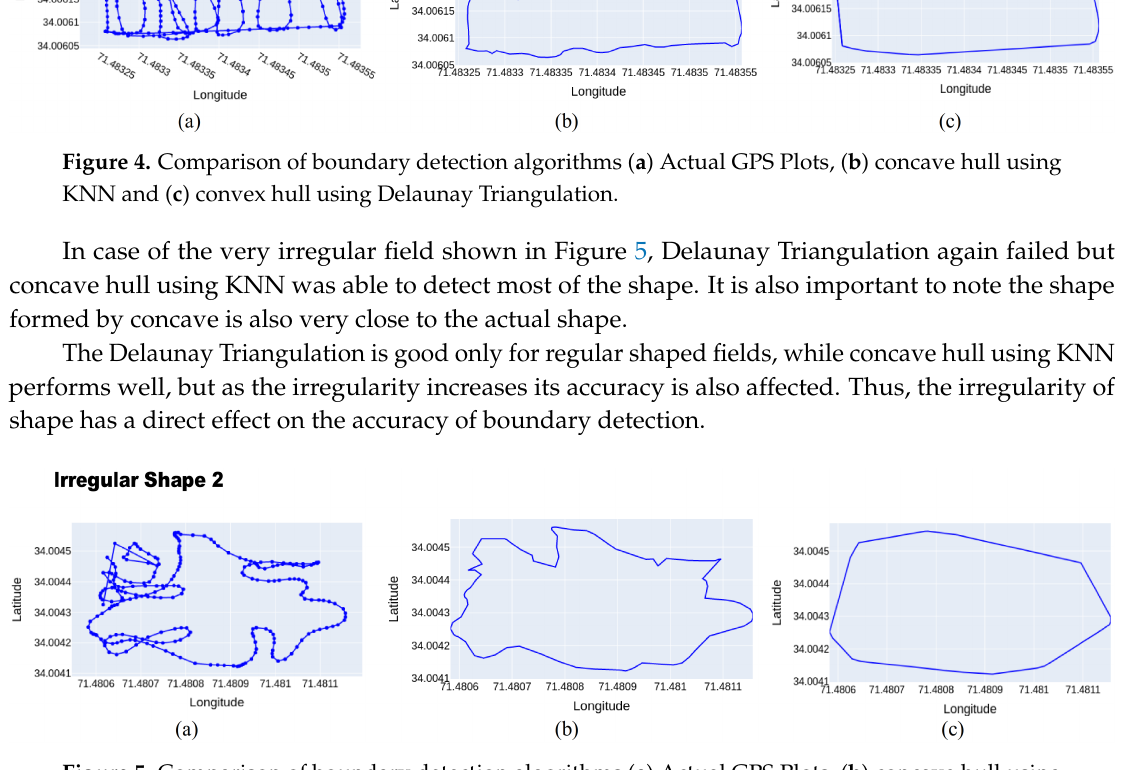
Figure 5. Comparison of boundary detection algorithms ( a ) Actual GPS Plots, ( b ) concave hull using KNN and ( c ) convex hull using Delaunay Triangulation.